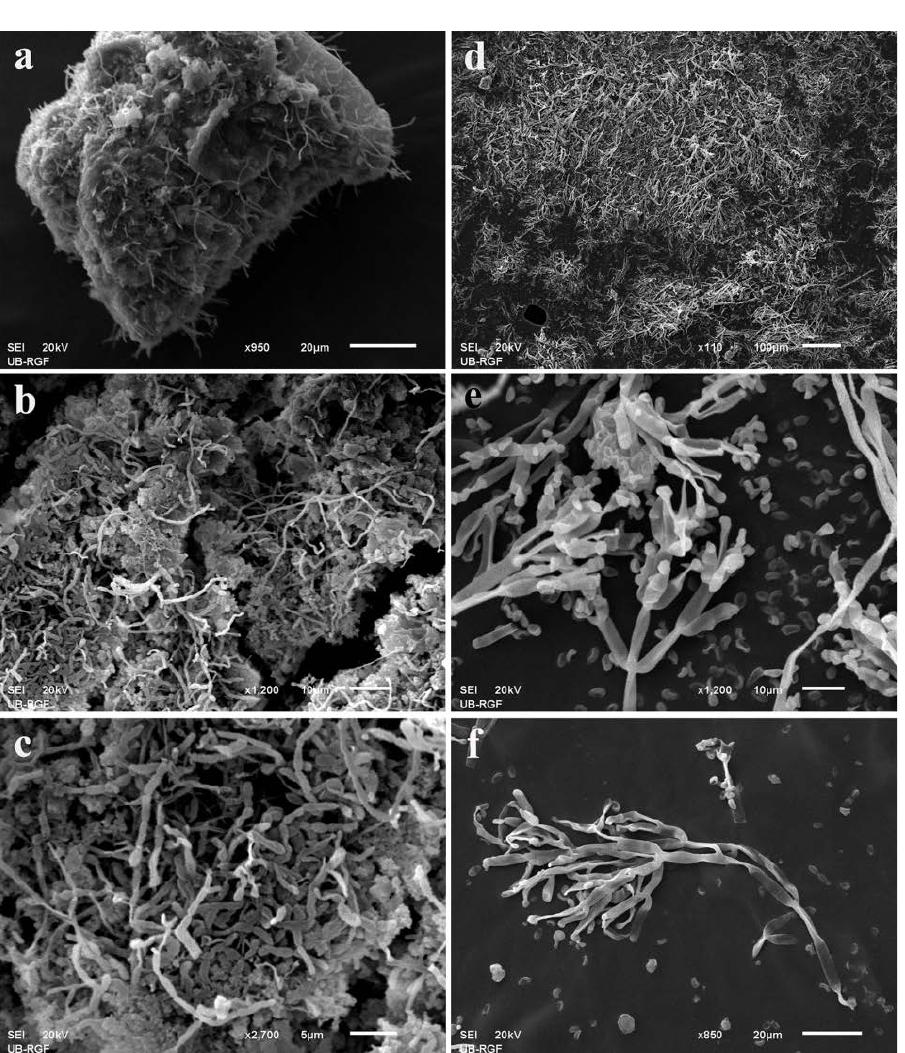
Figure 6. Scanning electron micrographs of fragments from deteriorated fresco painting and wooden iconostasis: ( a – c ) Neodevriesia conidial chains from wet grayish fresco discoloration; ( d – f ) branched conidiophores with conidia of the anamorphic state of Hypoxylon .